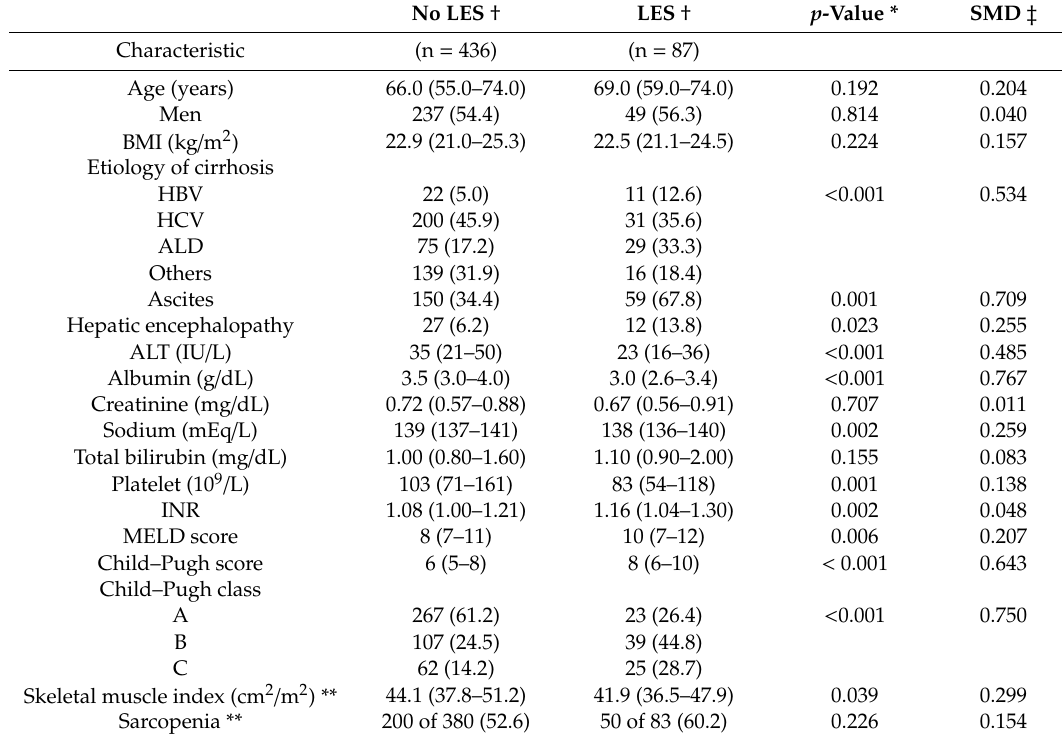
Table 1. Clinical characteristics of 87 LES-treated patients and 436 untreated patients. No LES † p -Value